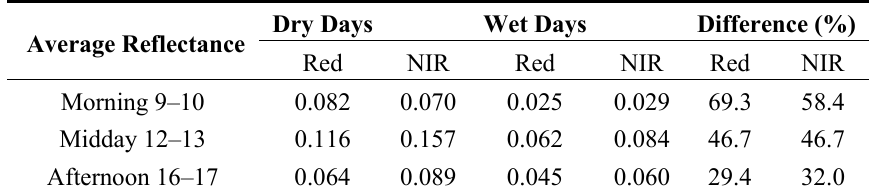
Table 4. Time of day specific averages of Red and Near Infrared (NIR) reflectance for dry and wet days respectively during the 2008 bare soil